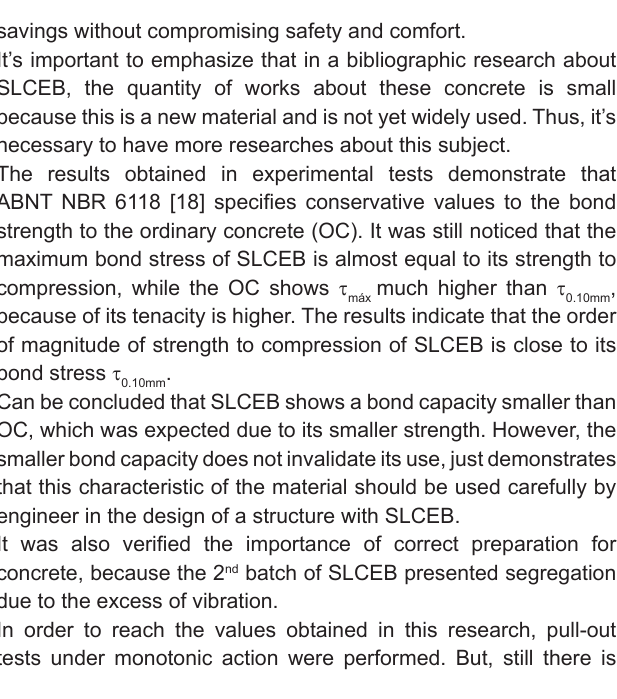
Table 11 Results of pull-out tests with models of 3 rd Batch of SLCEB